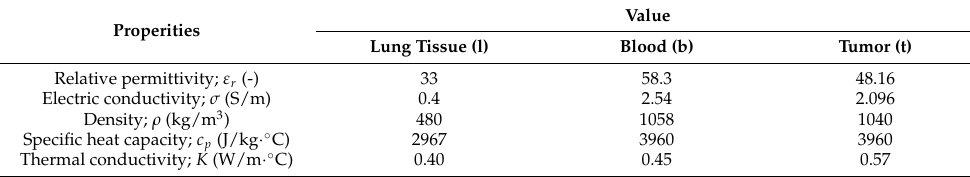
Table 1. The dielectric and thermal properties of tissue, blood and tumor [21,24].